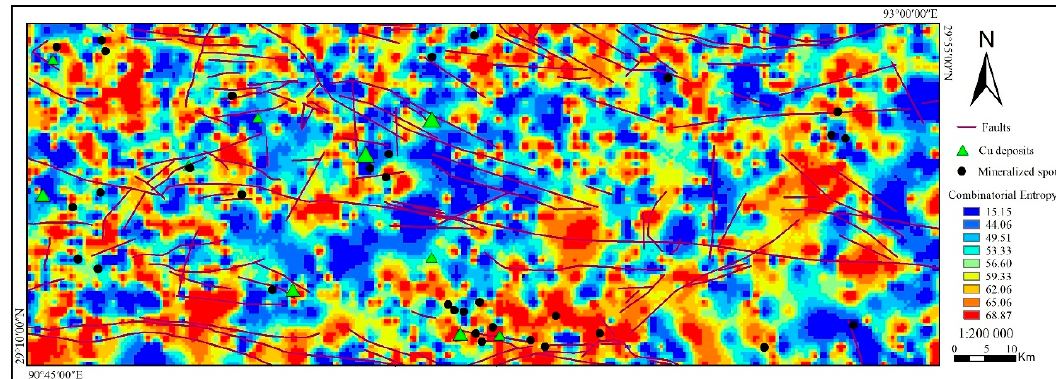
Figure 3. The stratigraphic combination entropy map.